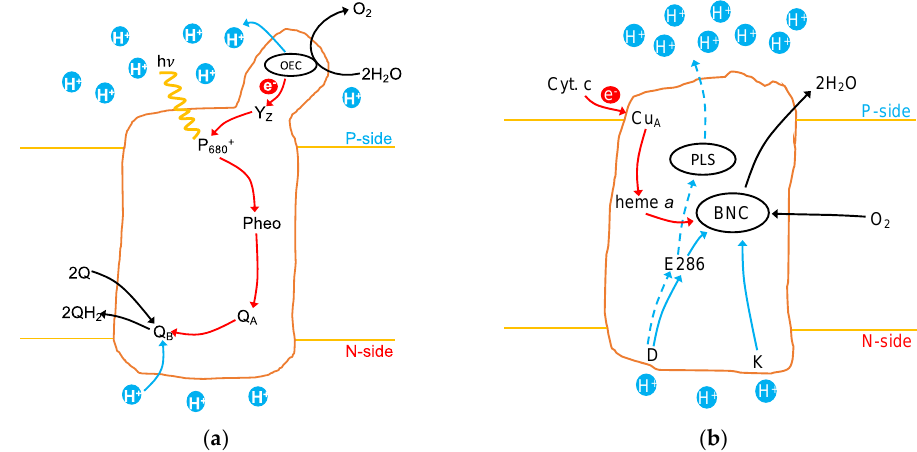
Figure 1. Schematic illustration of PSII and CcO showing key features of each mechanism. Red lines: electron transfer pathways; solid blue lines: chemical proton transfer pathways; dashed blue lines: pathways for pumped protons; black lines: substrate and product pathways. ( a ) In PSII the excited P + 680 , transfers an electron via a pheophytin (Pheo) and plastoquinone (Q A ) to a second plastoquinone